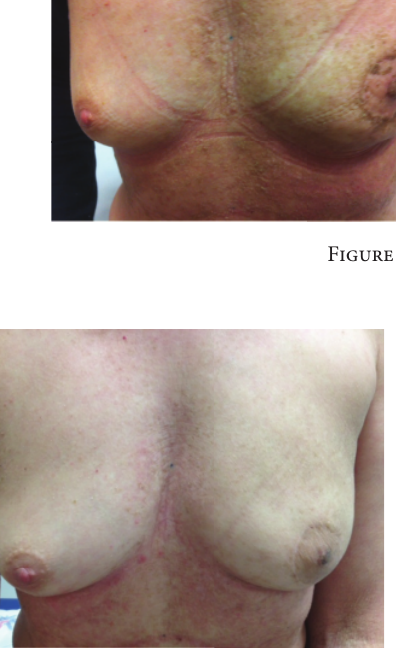
Figure 4: Skin features after 6